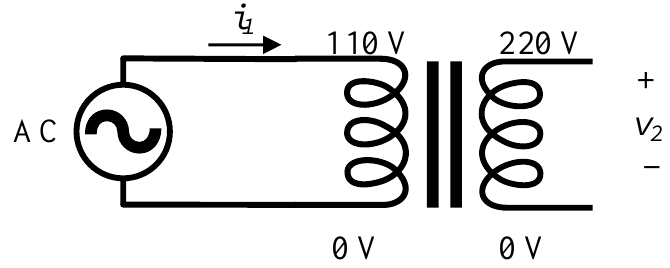
Figure 5. Circuit diagram without an integrator.